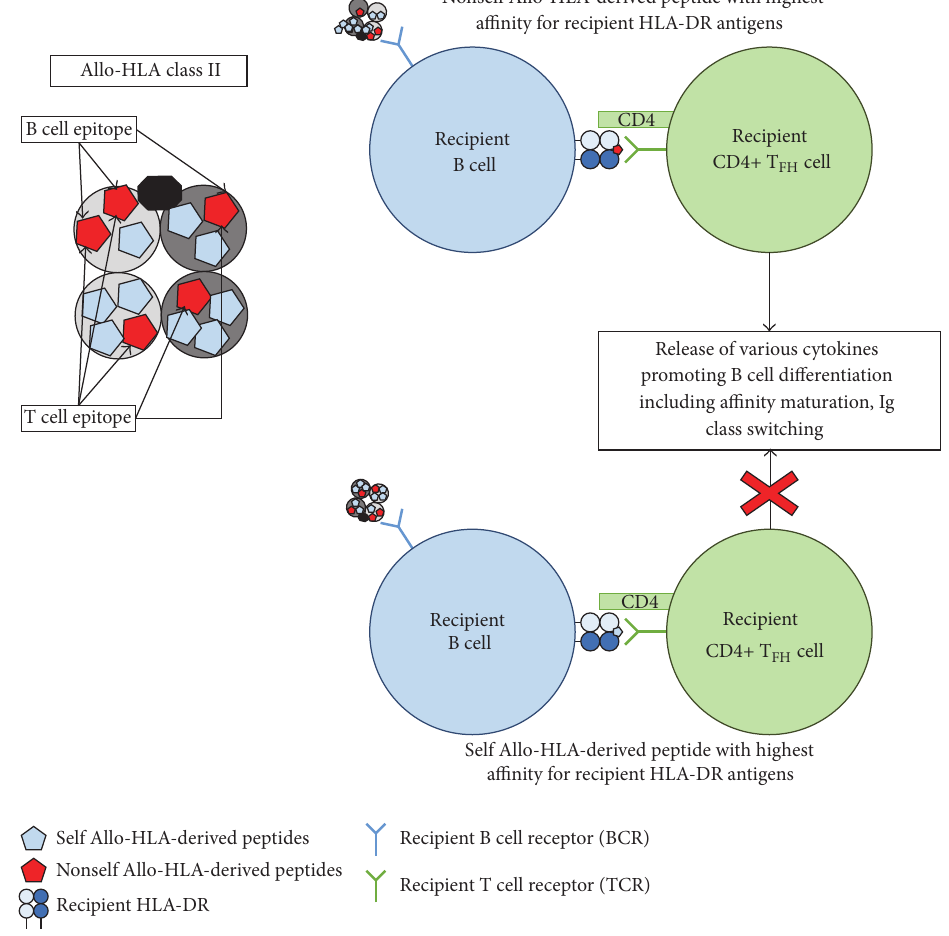
Figure 2: The indirect allorecognition pathway of allo-HLA class II by B cells and the presentation of self or nonself allo-HLA-derived peptide influence CD4+ T FH cells helper function to lead to the formation of DSA. HLA mismatches can become immunogenic when they carry both a B cell epitope and a T cell epitope. B cell epitopes are located on the molecular surface of HLA, whereas T cell epitopes can be located anywhere, exposed or cryptic. B cells expressing a BCR specific for an allo-HLA can capture, internalize, and process the whole allo-HLA class II molecule and then present allo-HLA-derived peptides on the cell surface. Only when CD4+ T FH cells recognize nonself antigenic determinants presented by B cells does the release of various cytokines promote B cell differentiation. This, in turn, may induce affinity maturation and Ig class switching, which eventually leads to the formation of